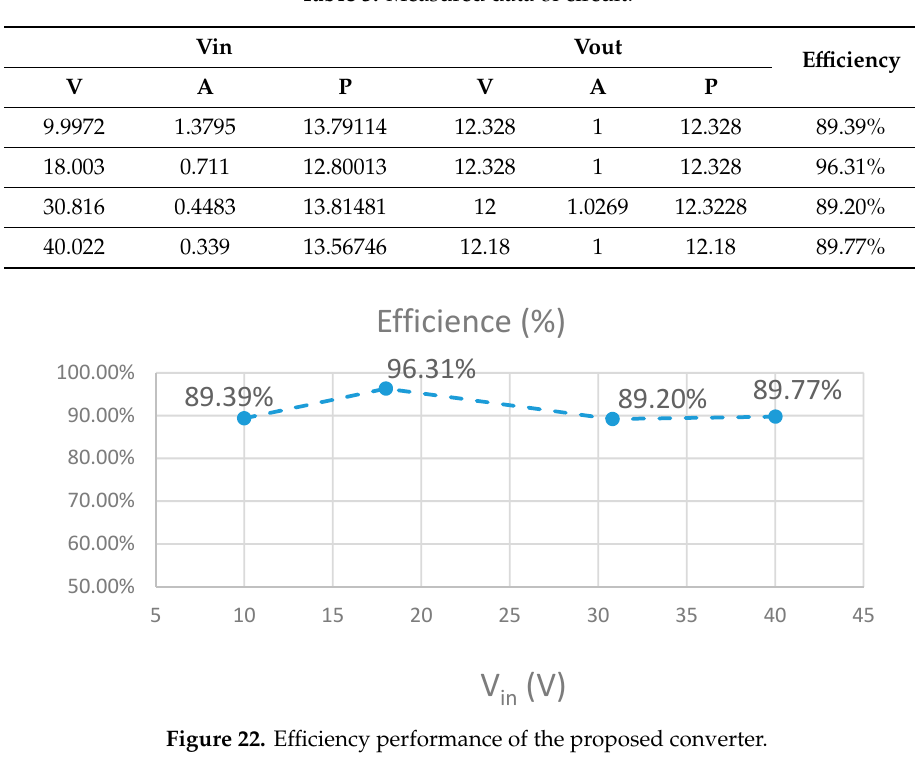
Figure 22. Efficiency performance of the proposed converter.